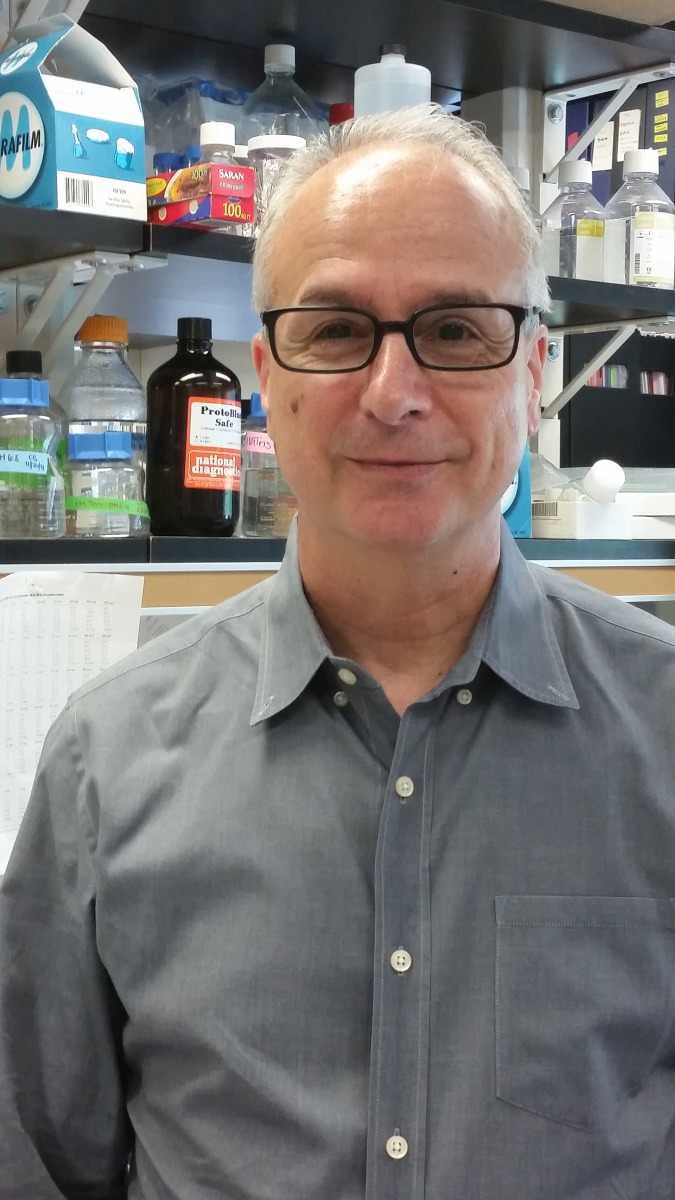
Michael J. Imperiale.